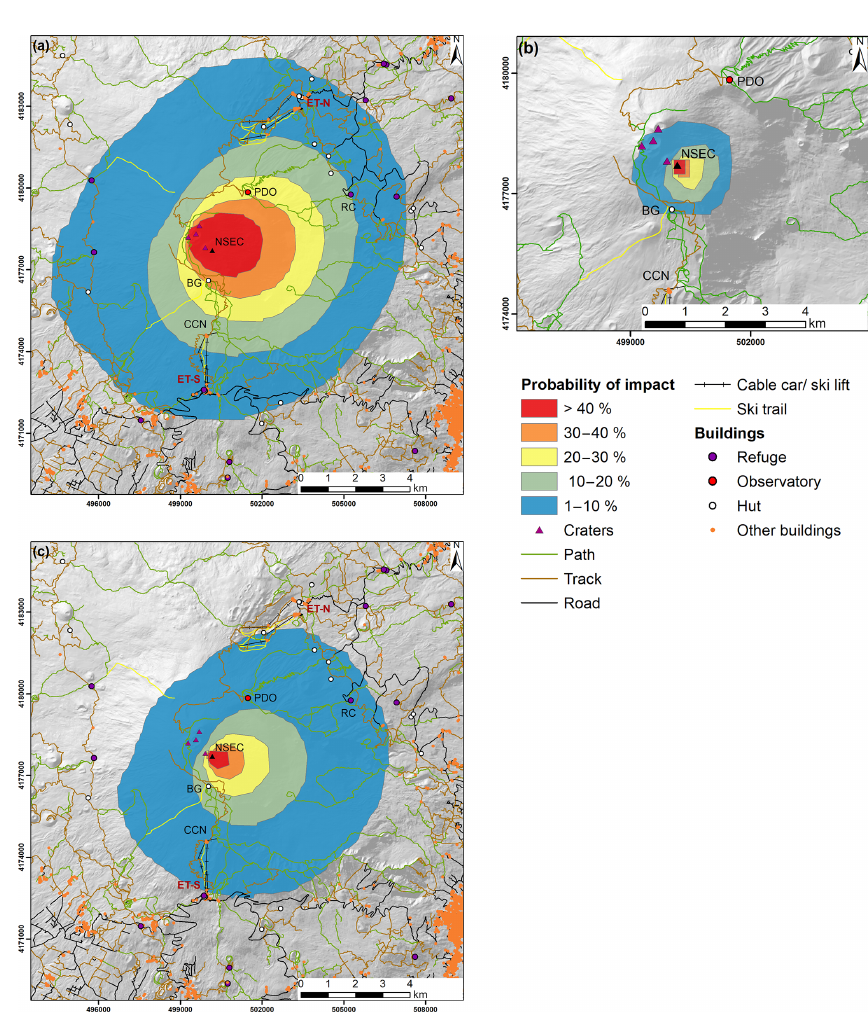
Figure 3. Probability map showing exposure of infrastructure to impact from a 5cm clast for (a) the OES–HMER, (b) the OES–LMER and (c) the ERS. NSEC: New Southeast Crater. Ski areas: ET-N: Etna Nord; ET-S: Etna Sud. BG: Baita delle Guide; CCN: top station of